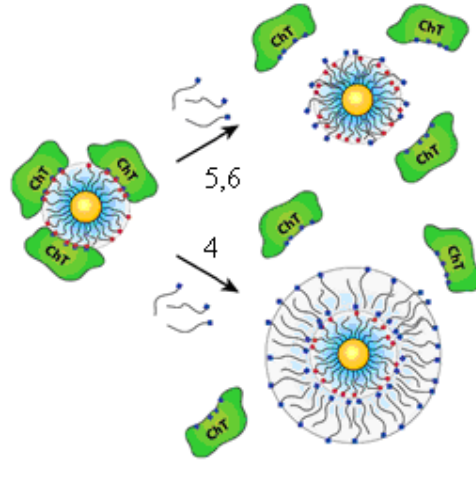
Figure 3. Proposed mechanism of ChT rescue. The surfactants with thiol 5 and alcohol 6 at their terminals have the ability to elict ChT release by interaction and/or partial alkane 4 forms a bilayer-like structure, causing displacement of the anionic monolayer. C 11 release of the ChT (red = anionic; blue = cationic) (reproduced with permission from [26] © 2003, American Chemical